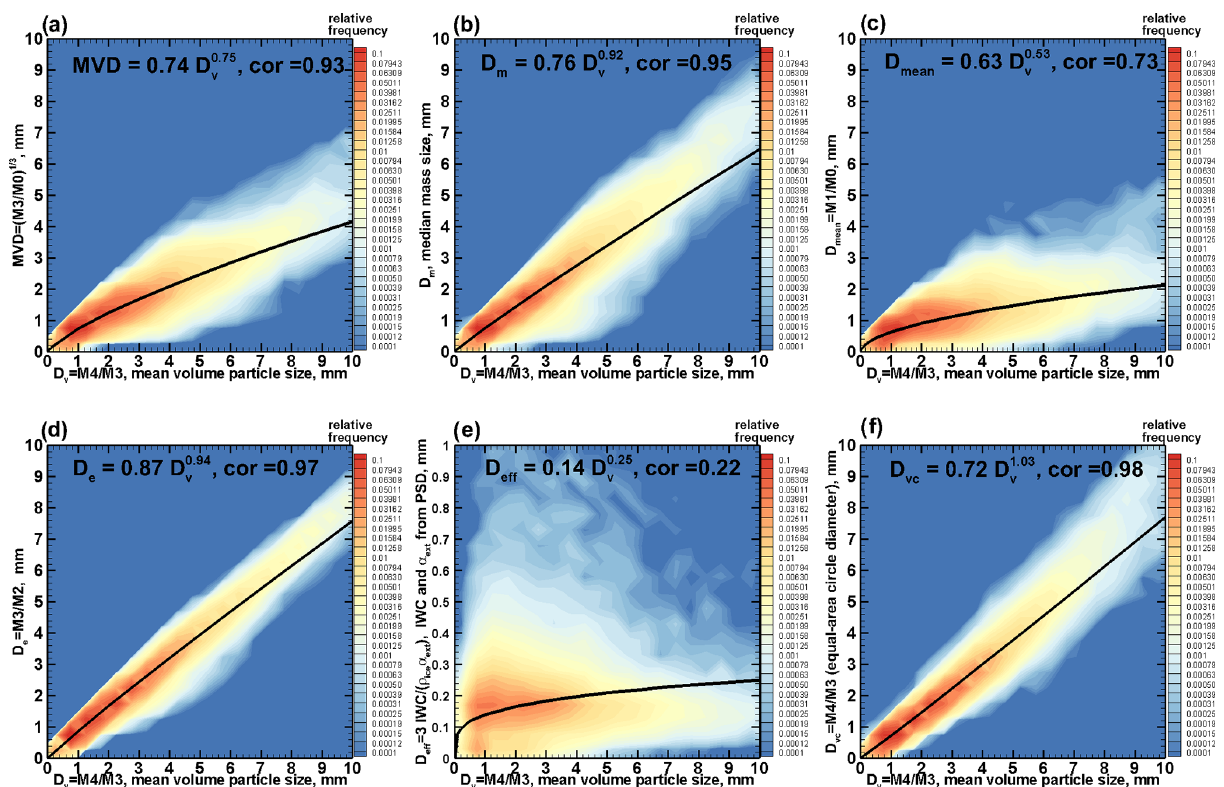
Figure 8. Observationally based statistical relations between (a) MDV and D v , (b) D m and D v , (c) D mean and D v , (d) D e and D v , (e) D eff and D v , and (f) D vc and D v according to the ICICLE in situ sampling data. Corresponding correlation coefficients are also shown. Note that the Y -axis scale in (e) is different from other